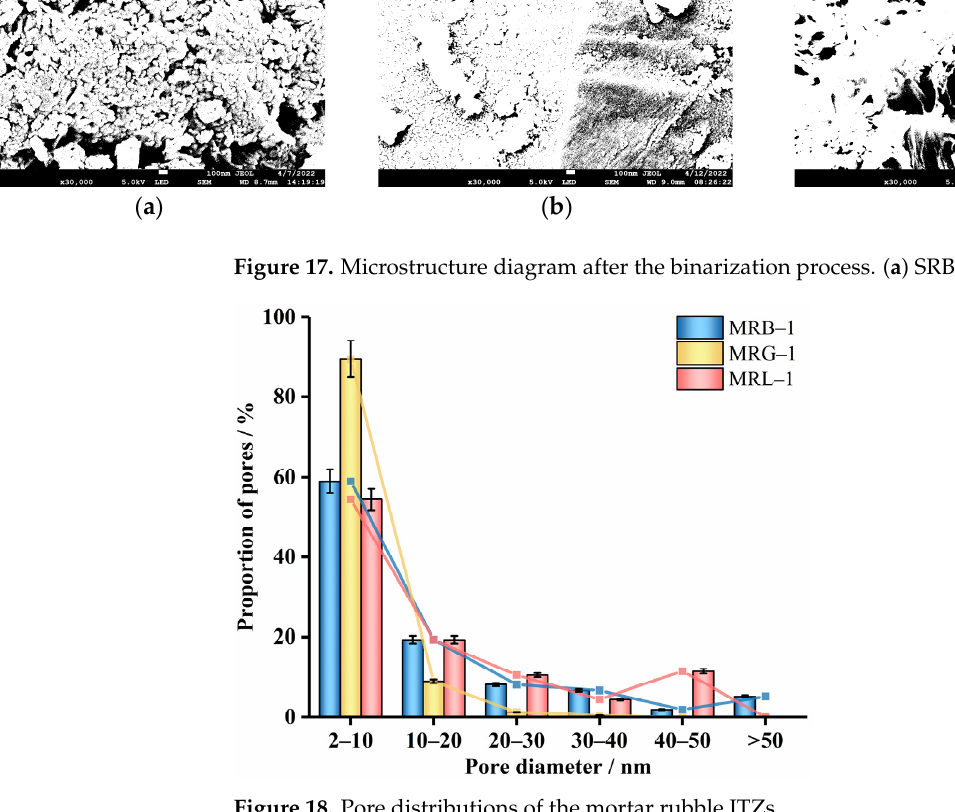
Figure 18. Pore distributions of the mortar rubble ITZs.